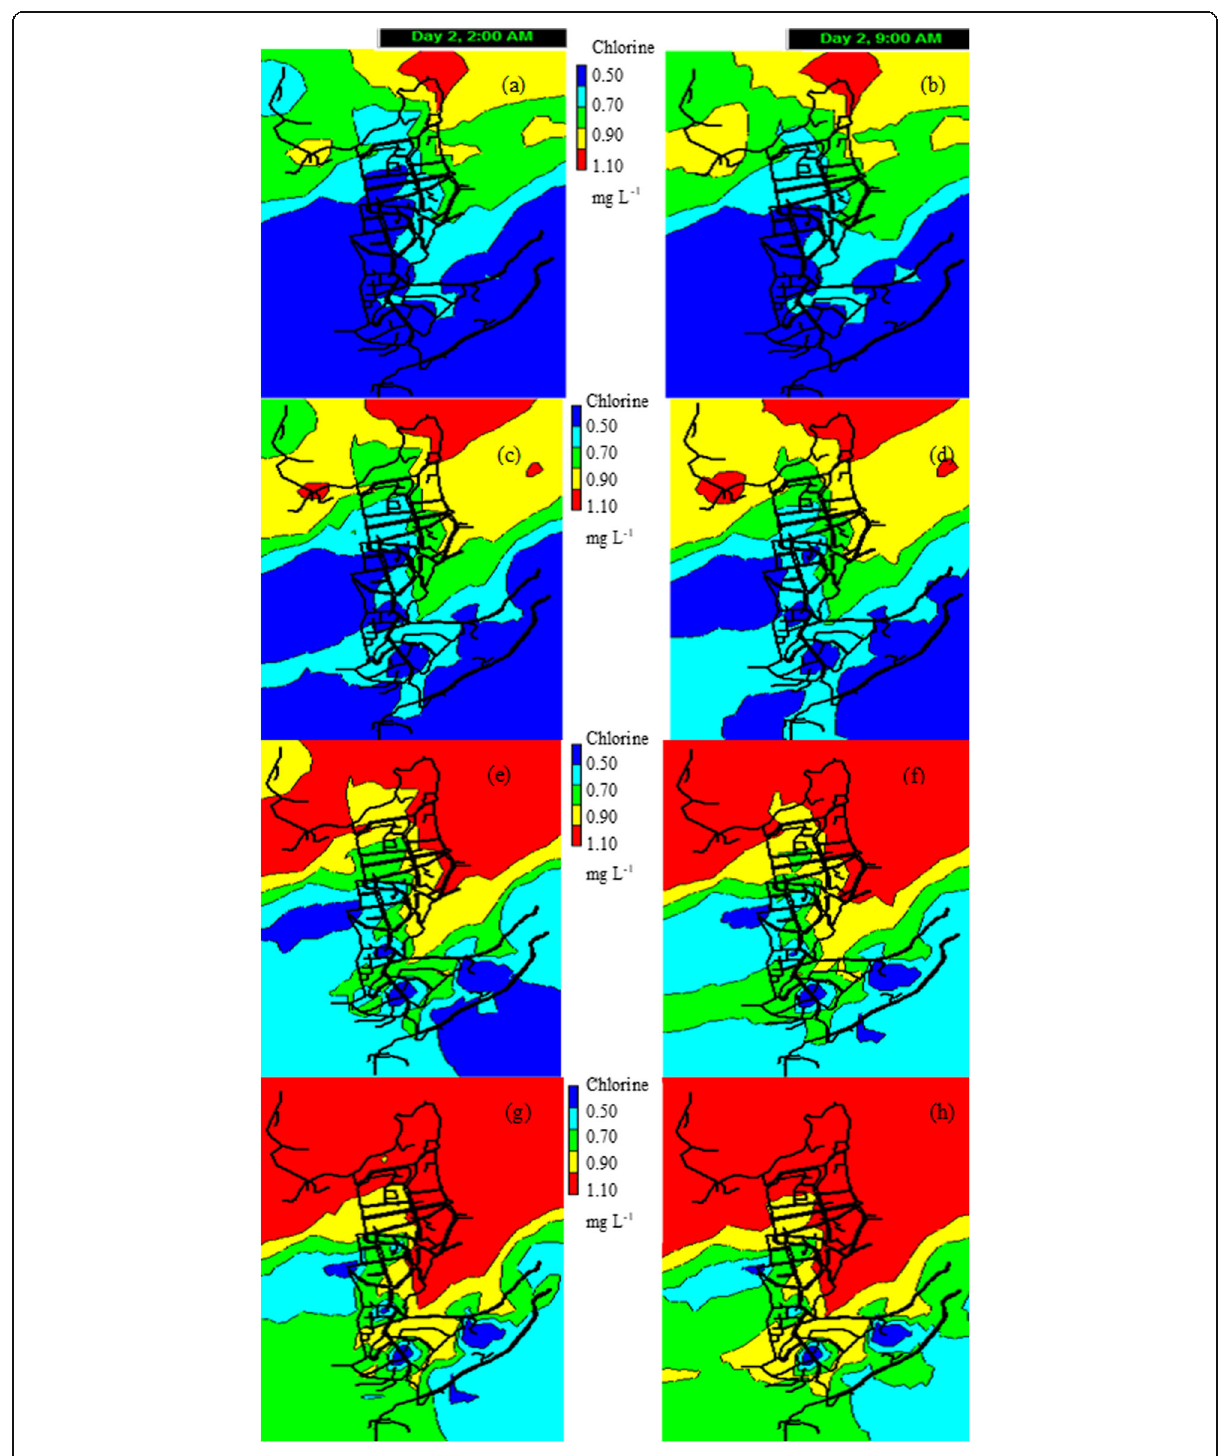
Fig. 10 Simulation results, using the proposed model for epidemiological control. Compliance analysis according to WHO, residual chlorine > 0.5 mg L − 1 . a When Co = 0.87 mg L − 1 in the distribution tank (DT), 2 am. b When Co = 0.87 mg L − 1 in DT, 9 am. c When Co = 1.2 mg L − 1 in DT, 2 am. d When Co = 1.2 mg L − 1 in DT, 9 am. e When Co = 1.5 mg L − 1 in DT, 2 am. f When Co = 1.5 mg L − 1 in DT, 9 am. g When Co = 2.0 mg L − 1 in DT, 2 am. h When Co = 2.0 mg L − 1 in DT, 9